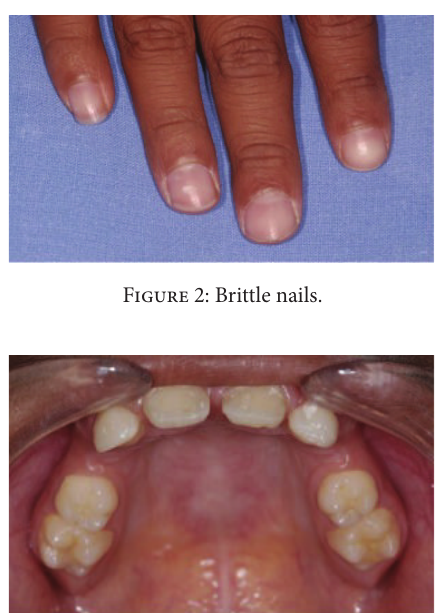
Figure 3: Intraoral view: mandibular edentulism and presence of permanent maxillary teeth 11, 16, 21, and 26 and deciduous teeth 52, 55, 62, and